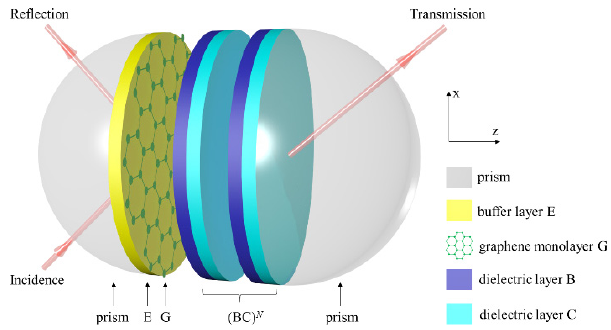
Fig. 1. Schematic of the structure of bu®er-graphene-1DPC multilayer. The evanescent wave is coupled into the structure through the prism or the surface of an oblique cross-section of a ¯ber under